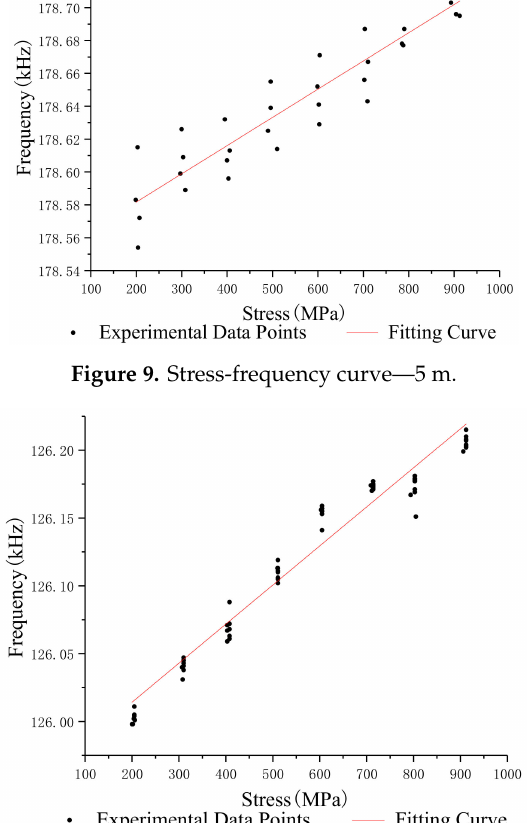
Figure 10. Stress-frequency curve—10